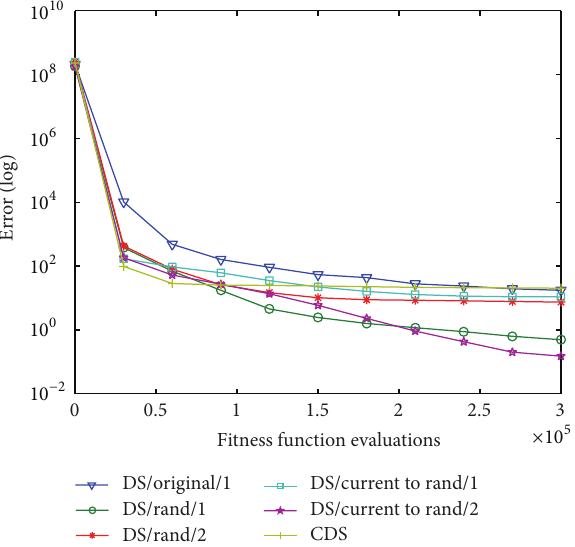
Figure 3: Comparison of performance of six algorithms for mini- mization of 𝑓 02 with dimension 30.